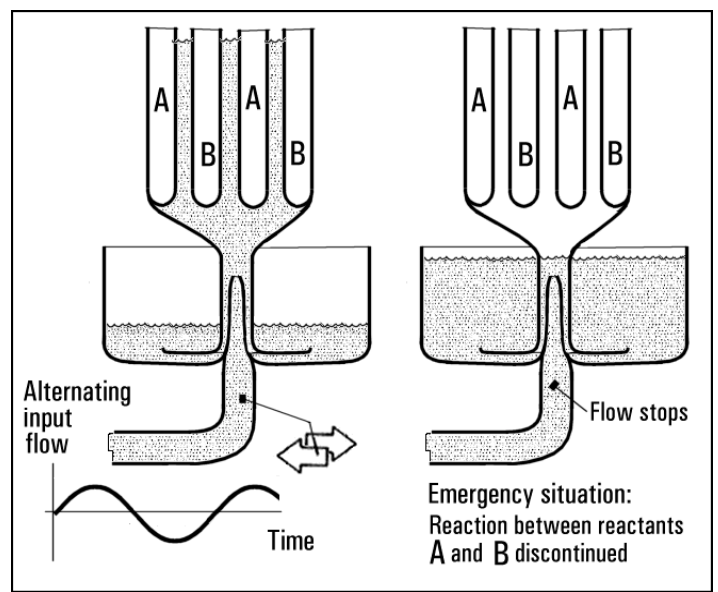
Figure 15. Reaction between two dangerous reactants A and B is discontinued in emergency situations by removal of the mediator liquid (e.g., a catalyst). This liquid is normally kept inside the reactor by the pressure generated by rectifying the input pulsation.